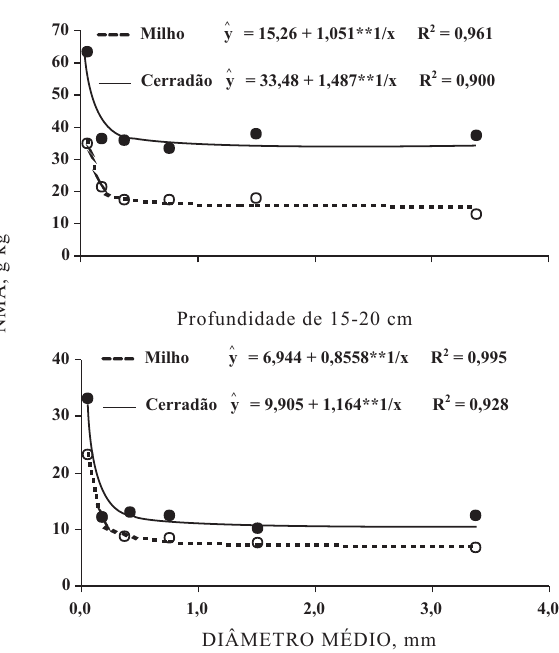
Figura 3. Nitrogênio mineralizado anaerobicamente (NMA), em relação ao diâmetro médio dos agre- gados, nas profundidades de 5–10 e 15–20 cm de um Latossolo Vermelho sob vegetação natu- ral de Cerradão e sob cultivo com milho por 30 anos. **: significativo a 1 % pelo teste t.